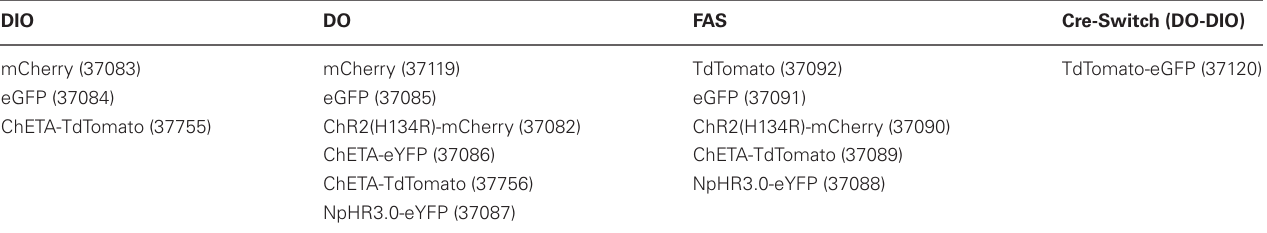
Table 1 | rAAV vectors and